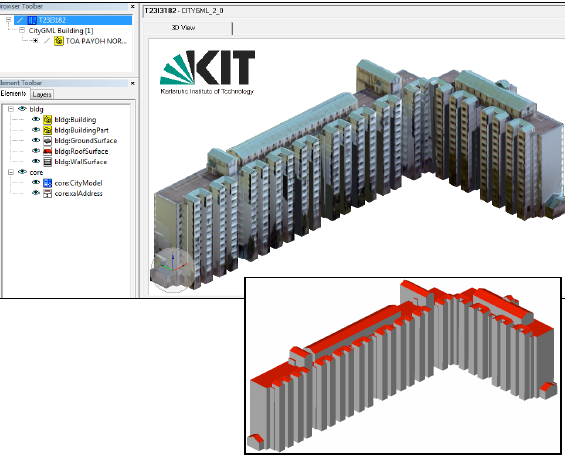
Figure 6. LOD 2 Building